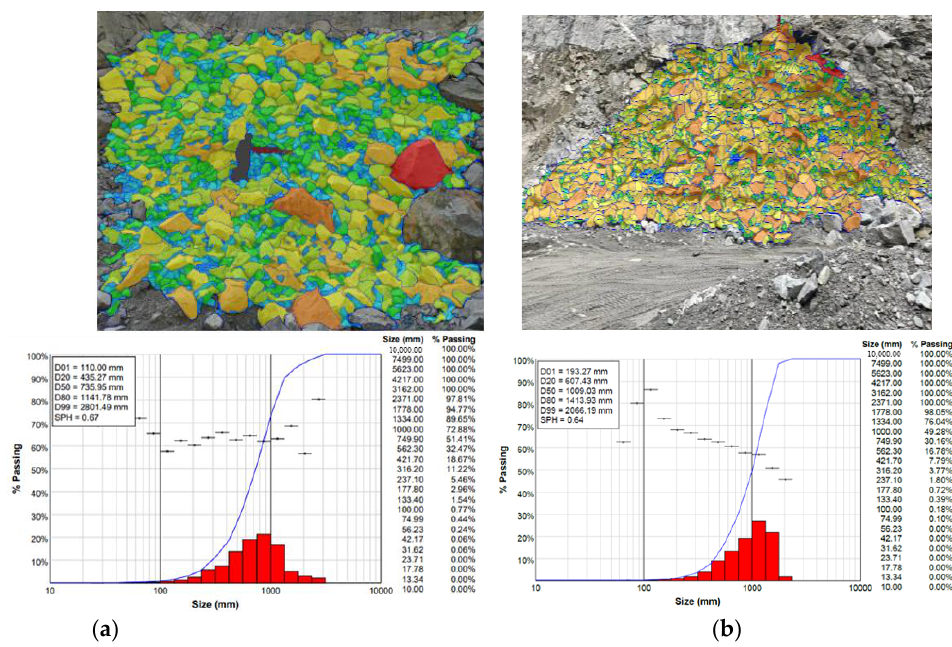
Figure 6. Fragment-size distribution: ( a ) explosive; ( b ) L-CDRB.